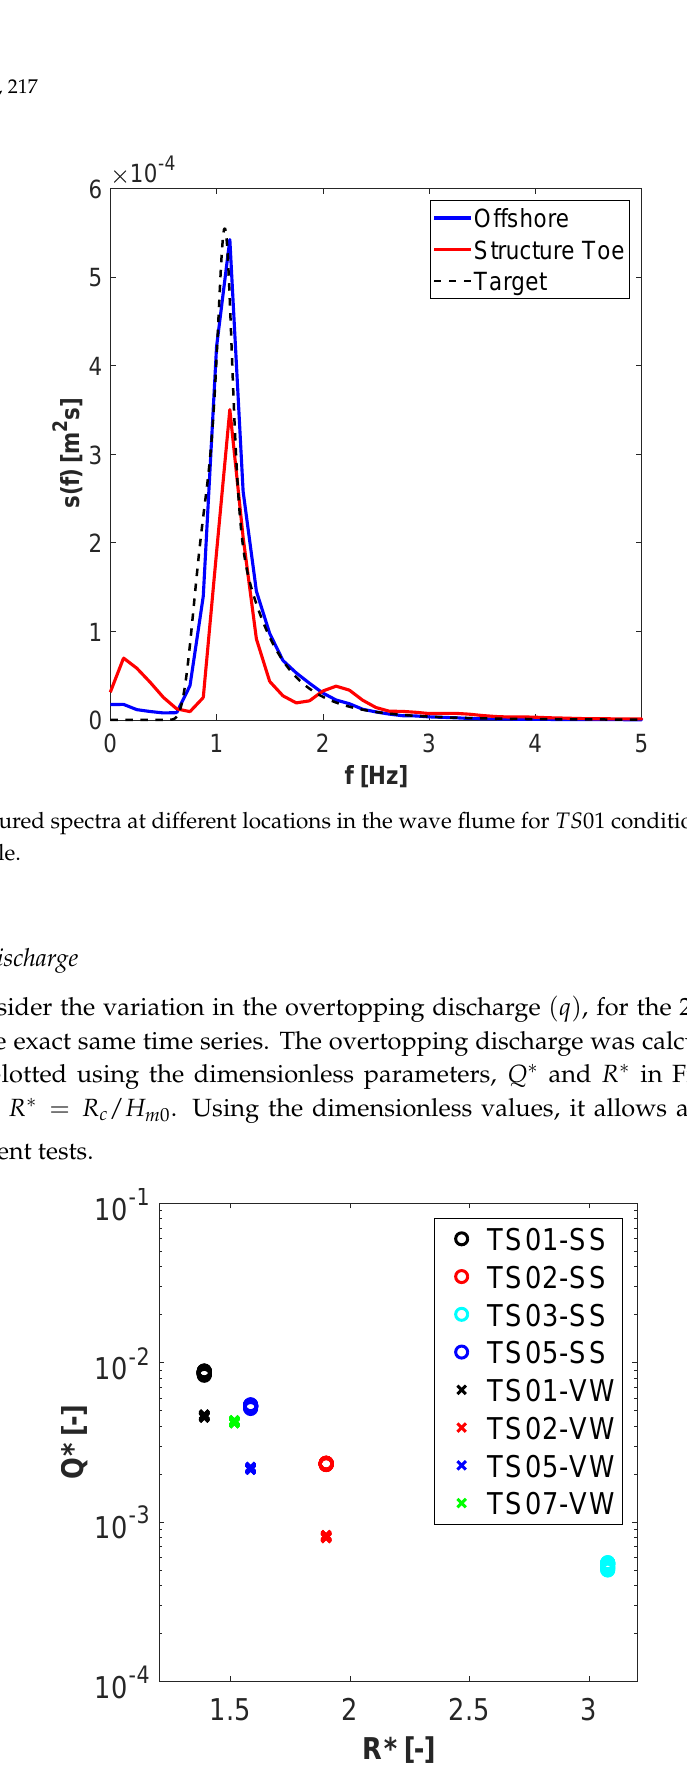
Figure 5. Graph showing R ∗ plotted against Q ∗ for each test conditions with identical offshore wave time